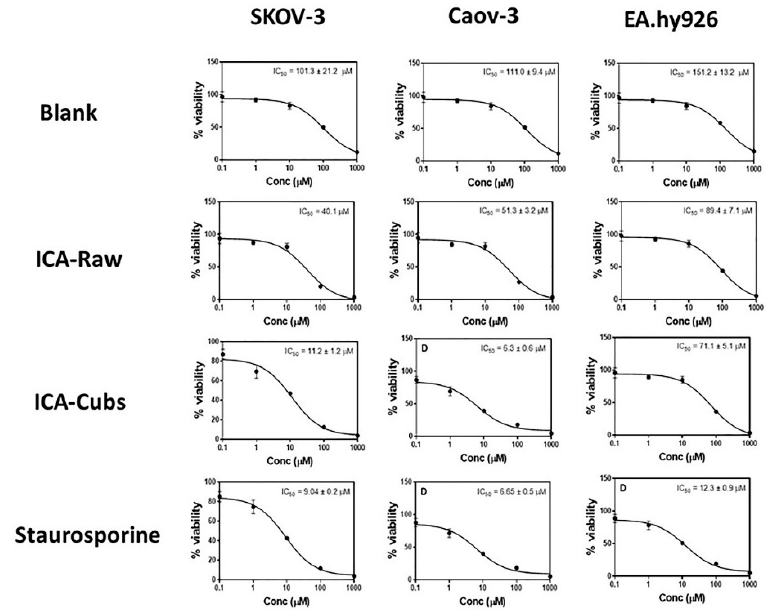
Figure 8. Dose response curves for the blank-Cubs, ICA-raw, ICA-Cubs and Staurosporine against the SKOV-3, Caov-3, and EA.hy926 cell lines. Data are expressed as the mean ± SD (n = 4 runs). The ICA-Cubs was found to inhibit the G0-G1-phase and S-phase, where arrest occurred significantly compared with the control and the blank-Cubs. Similarly, relative cell cycle enhancement in the G2-M-phase and pre-G1-phase was also observed significantly compared with the control, blank-Cubs, and ICA-Cubs, as shown in Figure 9.